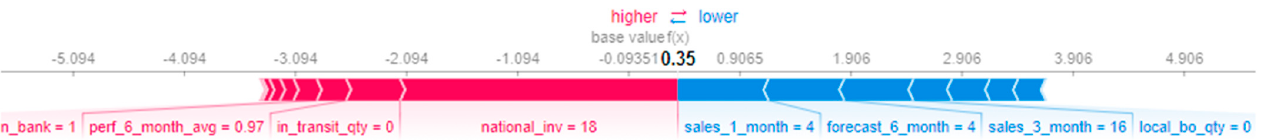
Figure 7. Beeswarm plot of LightGBM calibrated with the Isotonic Regression method for the backordered class.